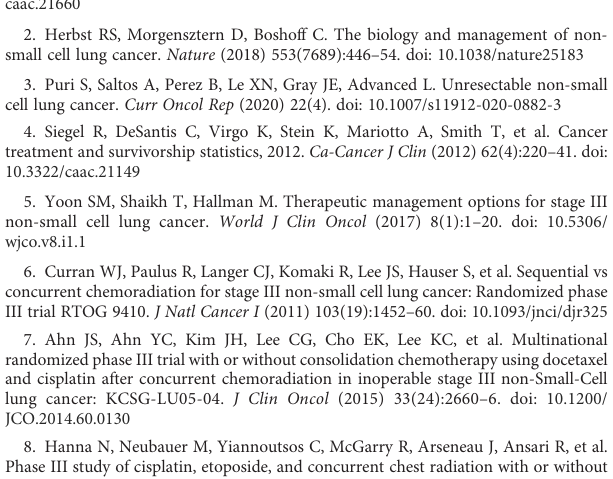
SUPPLEMENTARY FIGURE 1 Flow chart for patient enrolment. NSCLC, non-small-cell lung cancer; SCRT, sequential chemoradiotherapy. SUPPLEMENTARY FIGURE 2 Kaplan-Meier plots for PFS in subgroups of smoking status (A) , ECOG performance status (B) , radiotherapy dose (C) and induction therapy cycles (D) SCRT, sequential chemoradiotherapy; ECOG, Eastern Cooperative Oncology